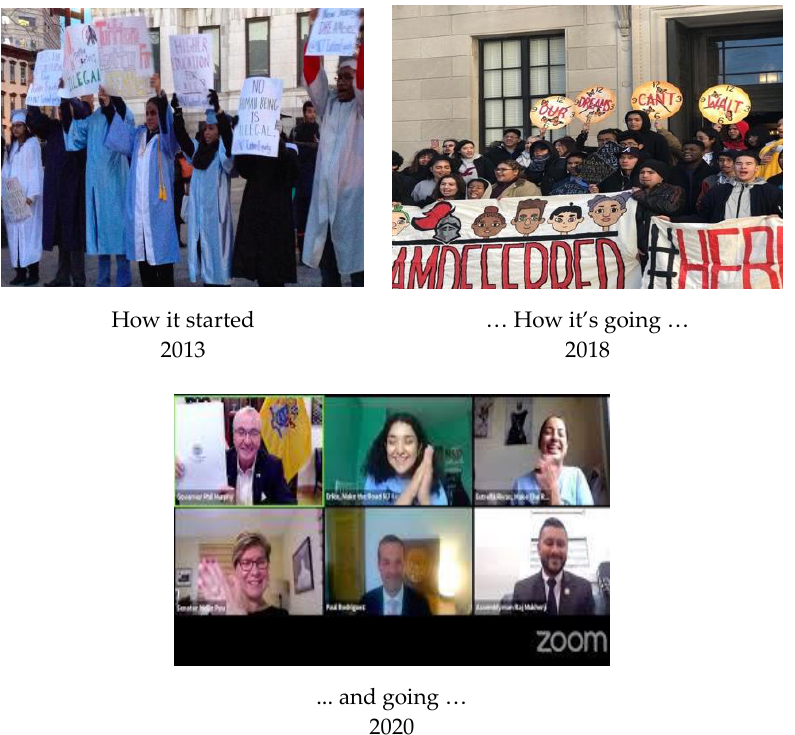
Figure 1. NJ organizing 2013–2020; Photo credit Anakbayan New Jersey and Make the Road New Jersey.